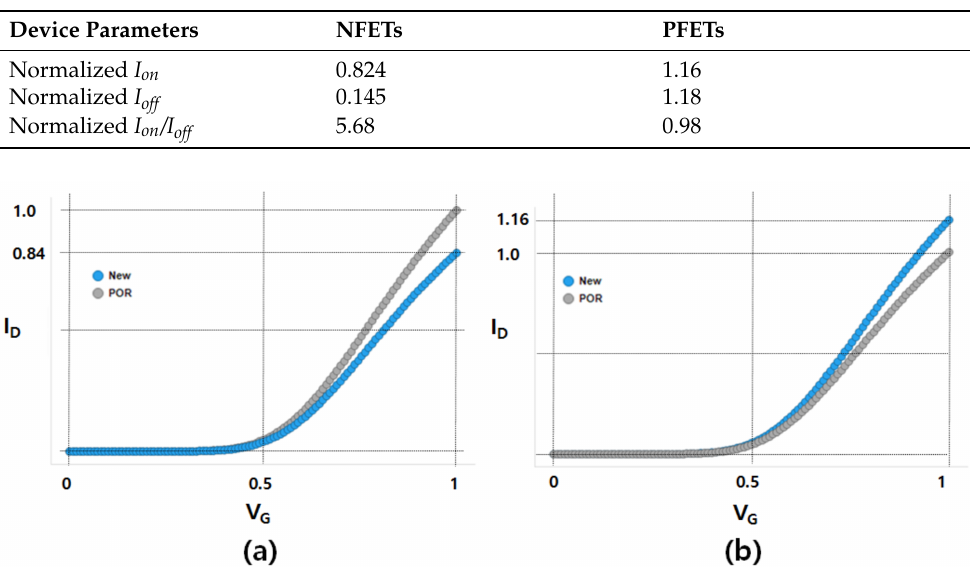
Figure 5. Normalized I on vs. normalized I off of ( a ) NFET and ( b ) PFET. Table 2. Normalized value for the new device.